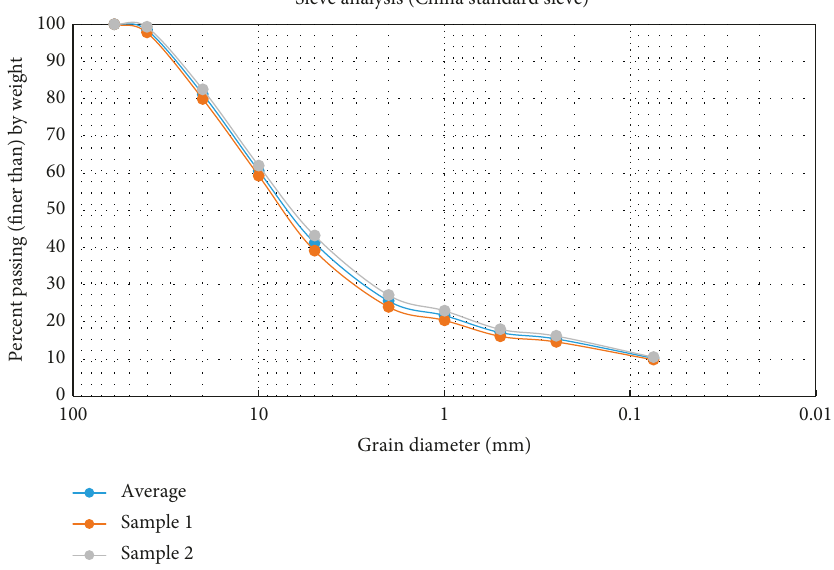
Figure 3: Grain size distributions of the natural